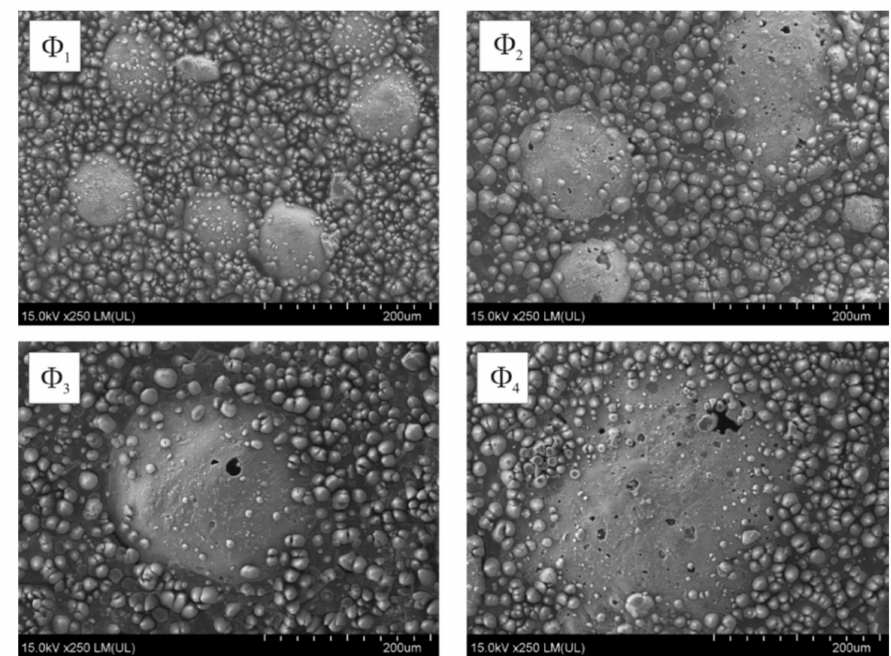
Figure 5. SEM images of laser irradiated (N = 500; E j = 100 mJ/cm 2 ) coatings containing glass microspheres: Φ 1 , Φ 2 , Φ 3 and Φ 4 .